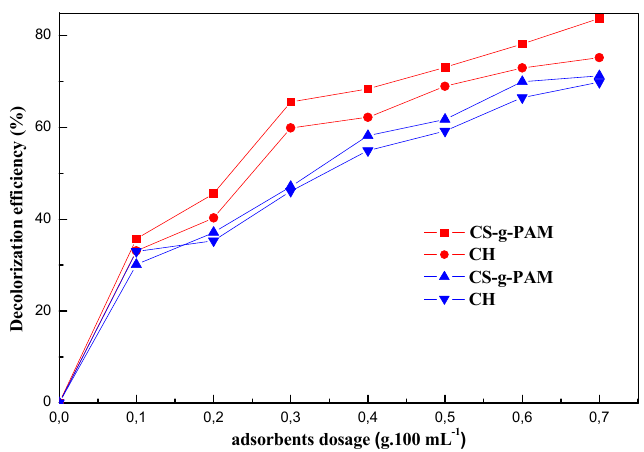
Figure 7. Effect of adsorbent dosage on dyes removal by CH and CS-g-PAM (pH 8.0 for MB and 5.0 for MO; initial MB/MO concentration: 8.0 mg/L; 25 °C).